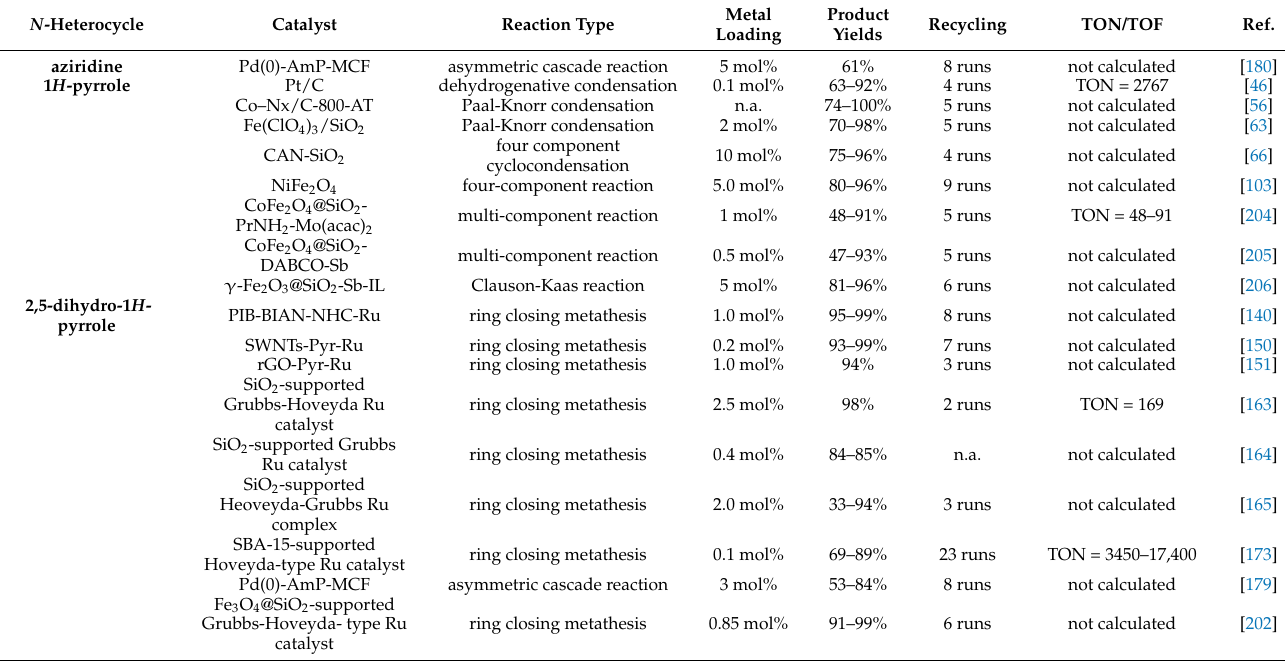
Table 1. Supported metal catalysts for the synthesis of N -heterocyclic compounds: an overview of the literature cited in the previous sections, organized depending on the class of the N